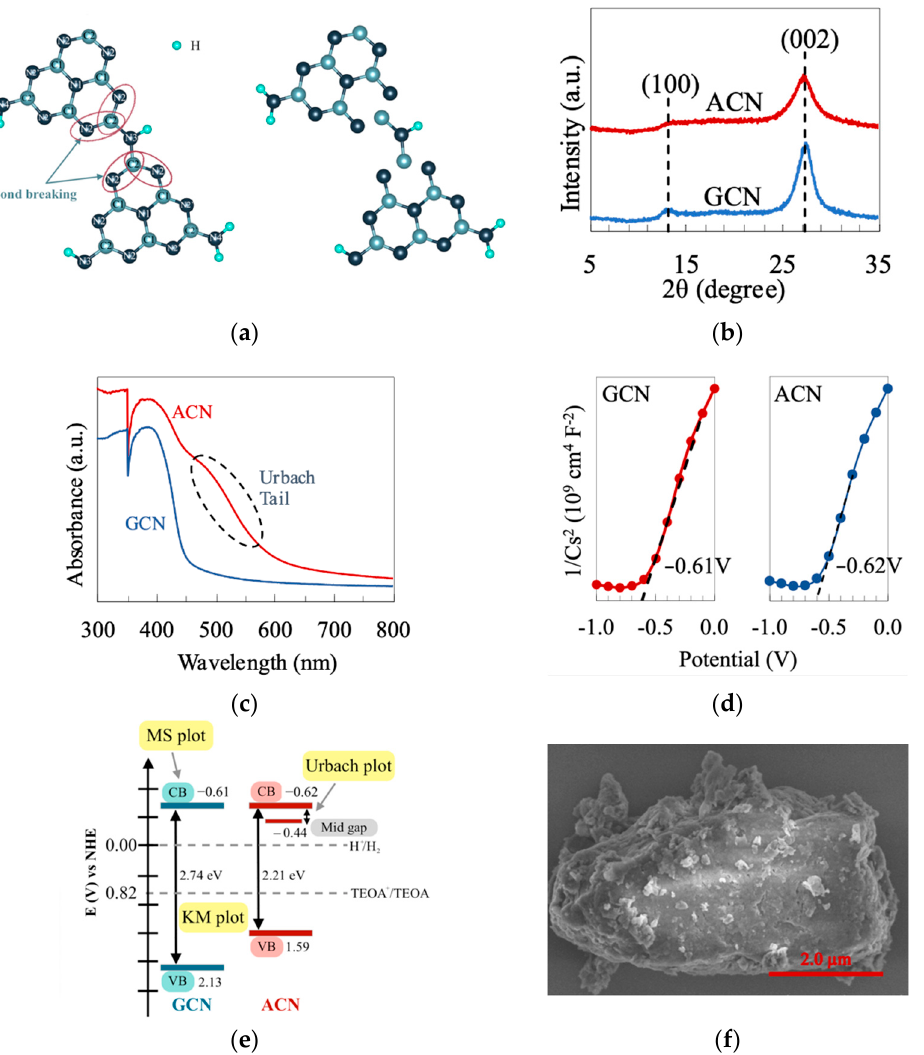
Figure 1. ( a ) Molecular structure of the repeating unit for GCN and ACN. ( b ) XRD patterns; ( c ) UV-Vis absorption spectra; ( d ) Mott–Schottky plots and ( e ) band structure diagram for GCN and ACN. ( f ) FESEM image of ACN.